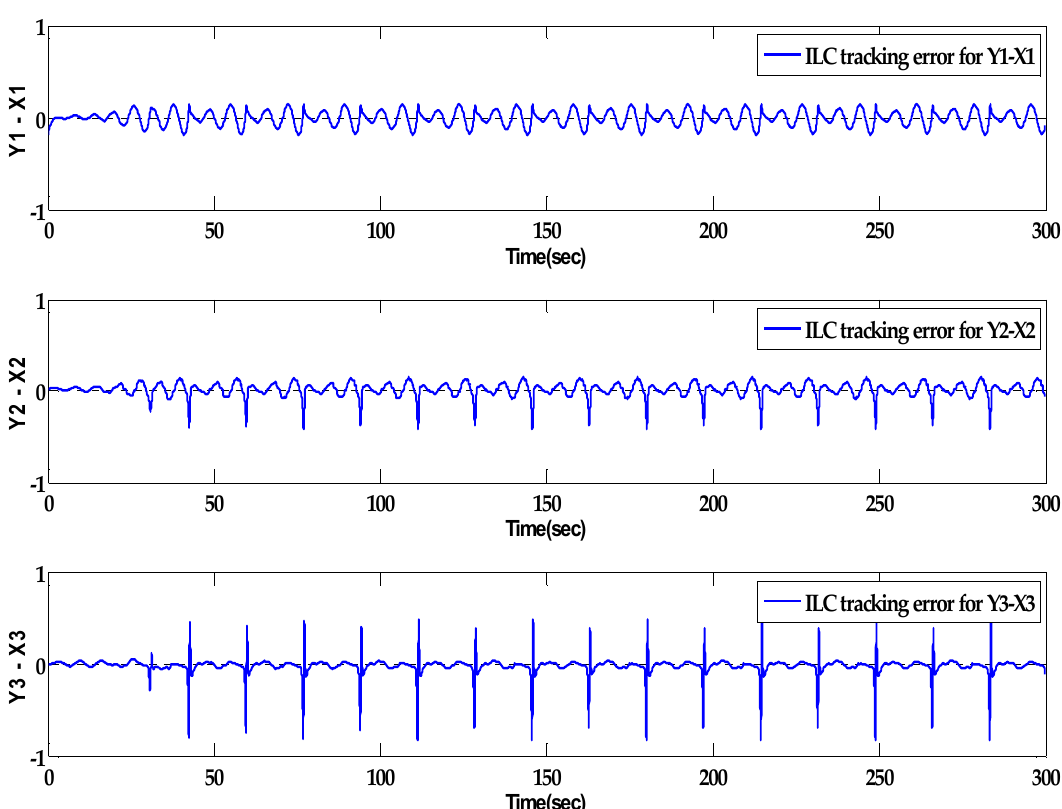
Figure 5. The phase portrait of x 1 ( y 1 ) and x 2 ( y 2 ) using the iterative learning control update law.